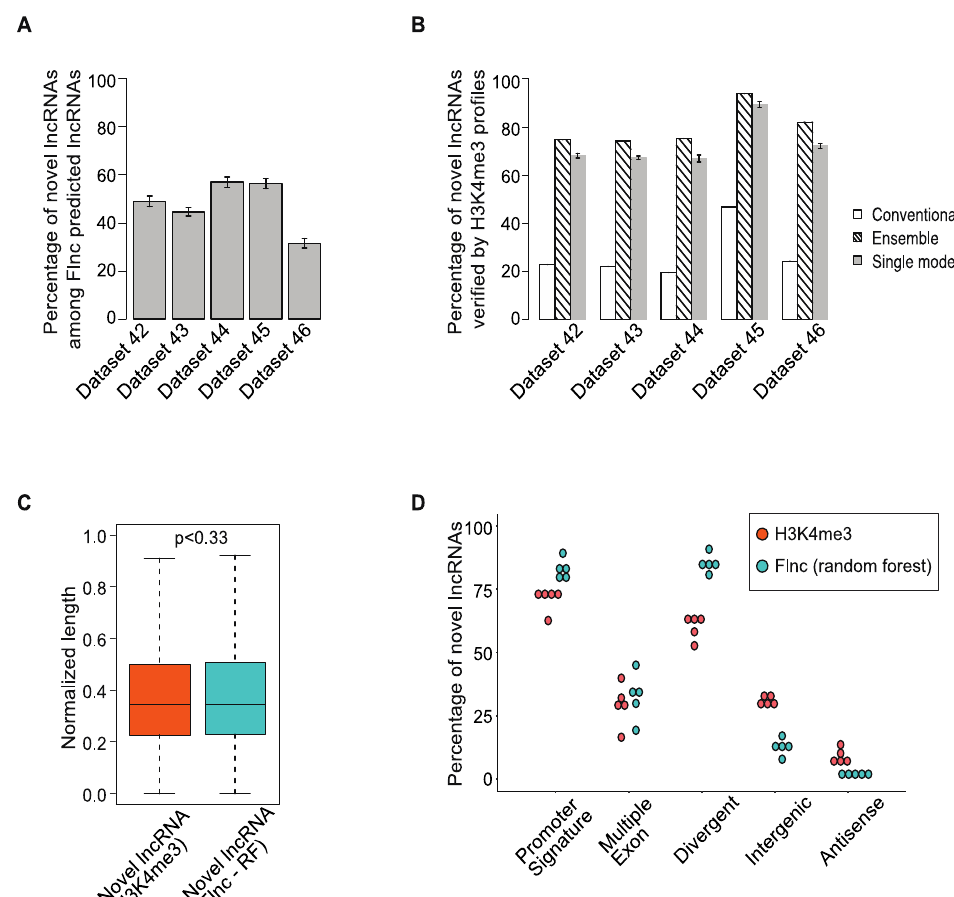
Figure 4. Most novel lncRNAs predicted by Flnc are supported by H3K4me3 profiles. ( A ) A large proportion of true lncRNAs predicted by Flnc are novel lncRNAs in the five individual test datasets. ( B ) The percentage of novel lncRNAs predicted by the conventional method without models and Flnc methods are verified by H3K3me3 profiles. Most novel lncRNAs predicted by the conventional method cannot be verified by H3K4me3 profiles, whereas most of the novel lncRNAs predicted by Flnc methods (ensemble approach or each of the seven single models) can be verified by H3K4me3 profiles. The error bars of the single model (gray) bars represent the standard deviations for the results of the seven ML models. ( C ) The novel lncRNAs predicted by Flnc (with random forest model) show similar normalized transcript length distribution as the novel lncRNAs determined by H3K4me3 ChIP-seq data. ( D ) The novel lncRNAs predicted by Flnc (with the random forest model) includes significantly more divergent transcripts and transcripts with promoter signatures than the novel lncRNAs determined by H3K4me3 ChIP-seq data, whereas multiple exon features exhibit similar percentage between these two groups of novel lncRNAs. Each dot represents one of the five independent datasets in the test set.